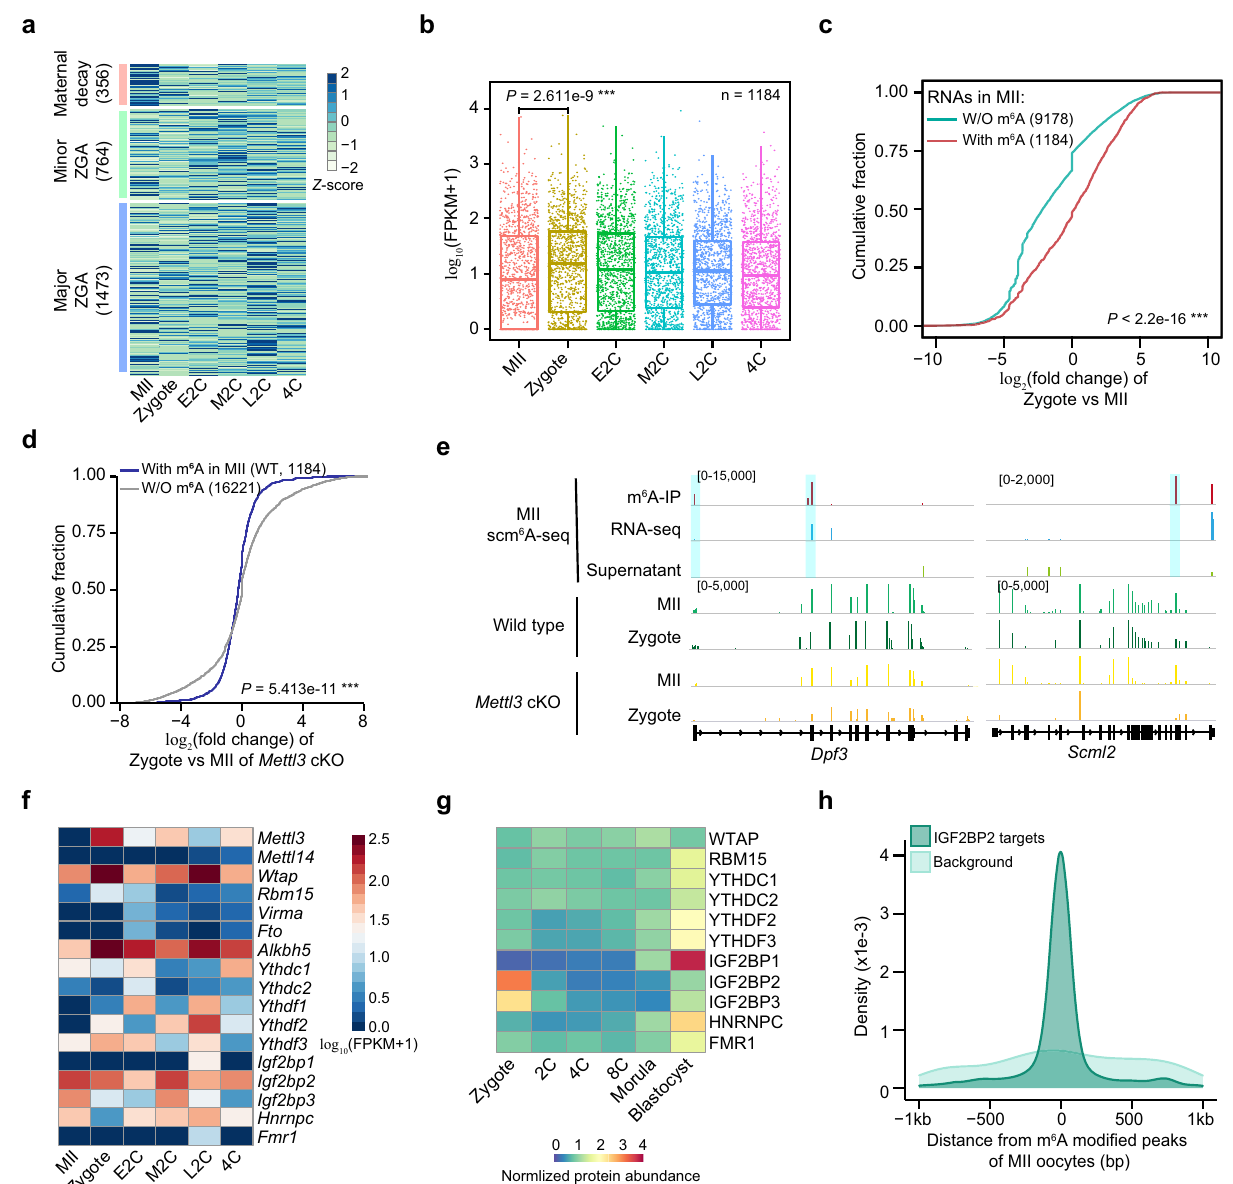
Fig. 5 | m 6 A regulates RNA stability during the oocyte-to-embryo transition. a Heatmap showing the normalized expression of signi fi cantly dysregulated RNAs between two adjacent time points during early embryo development. The expres- sionofmaternaldecaygenesistheupregulatedinMIIoocytes,thatofminorzygotic genomeactivation(ZGA)genesisupregulatedintheearlyandmid-2-cellstages,and thatofmajorZGAgenesisupregulated inthelate2-celland4-cellstages. b Boxand scatterplotshowingtheexpressionofm 6 A-modi fi edRNAsinoocytesfromtheMIIto the4-cellstage.Themiddlelinesoftheboxesrepresentthemediansofdatasets.The upper and bottom lines of the boxes are respectively the upper quantile and the lower quantile of the data. The whiskers mark the upper and lower limits of these datasets respectively. P values were determined by one-sided Wilcoxon test, P =2.611e − 9.*** P <0.001. c CumulativefractionofRNAexpressionchange(log 2